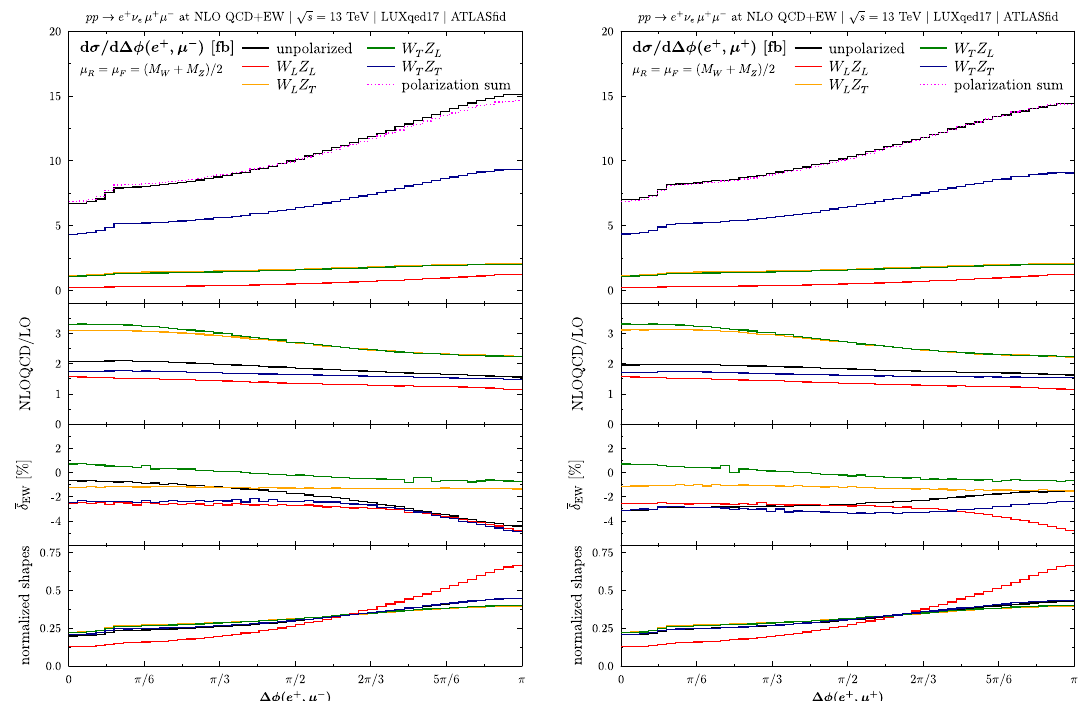
Fig. 4 Same as Fig. 3 but for the azimuthal angles between the momenta of the electron and the muons, (cid:9)φ( e + ,μ − ) (left) and (cid:9)φ( e + ,μ + )